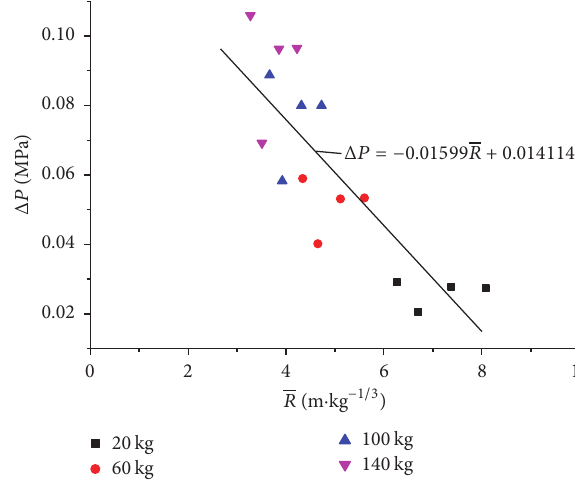
Figure 2: Relationship between reflection overpressure and scaled distance of typical measuring